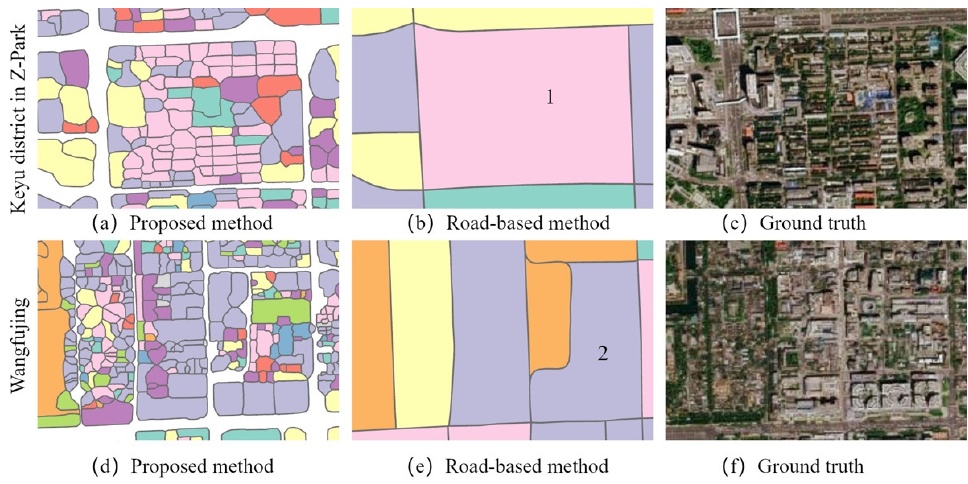
Figure 14. Illustration of UFZ mapping results with the different zone segmentation strategies. ( a , d ) Proposed method, ( b , e ) road-based method, ( c , f ) ground truth.